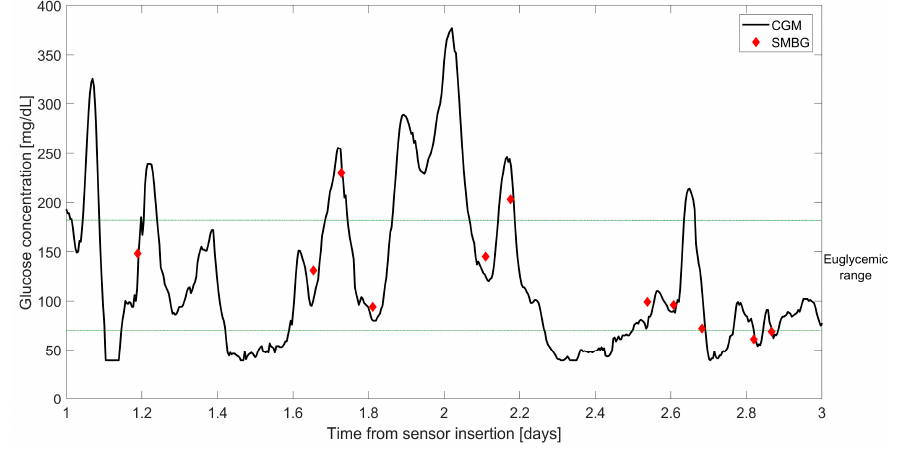
Figure 1. Representative three days of blood glucose (BG) monitoring obtained with self-monitoring BG (SMBG), diamonds, and with continuous glucose monitoring (CGM), continuous line. Horizontal dashed lines indicate the euglycemic range. Data taken from a previously published study [15].